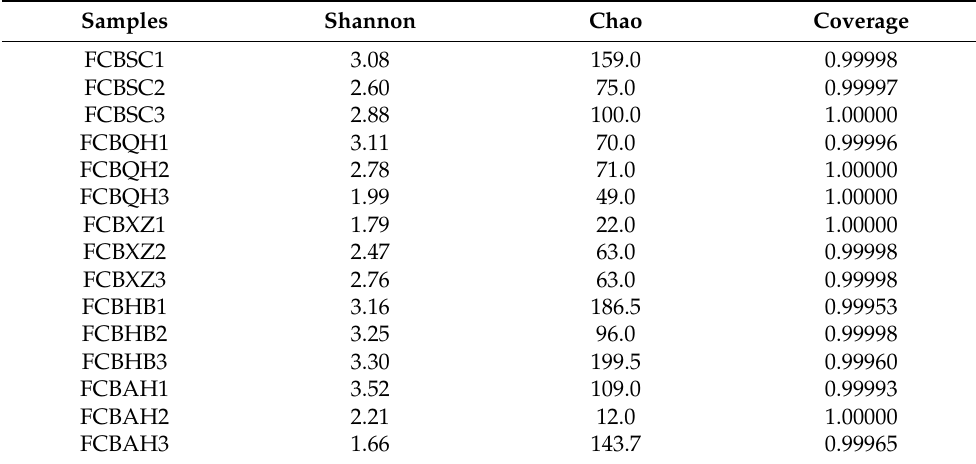
Table 2. Alpha diversity indexes of FCB